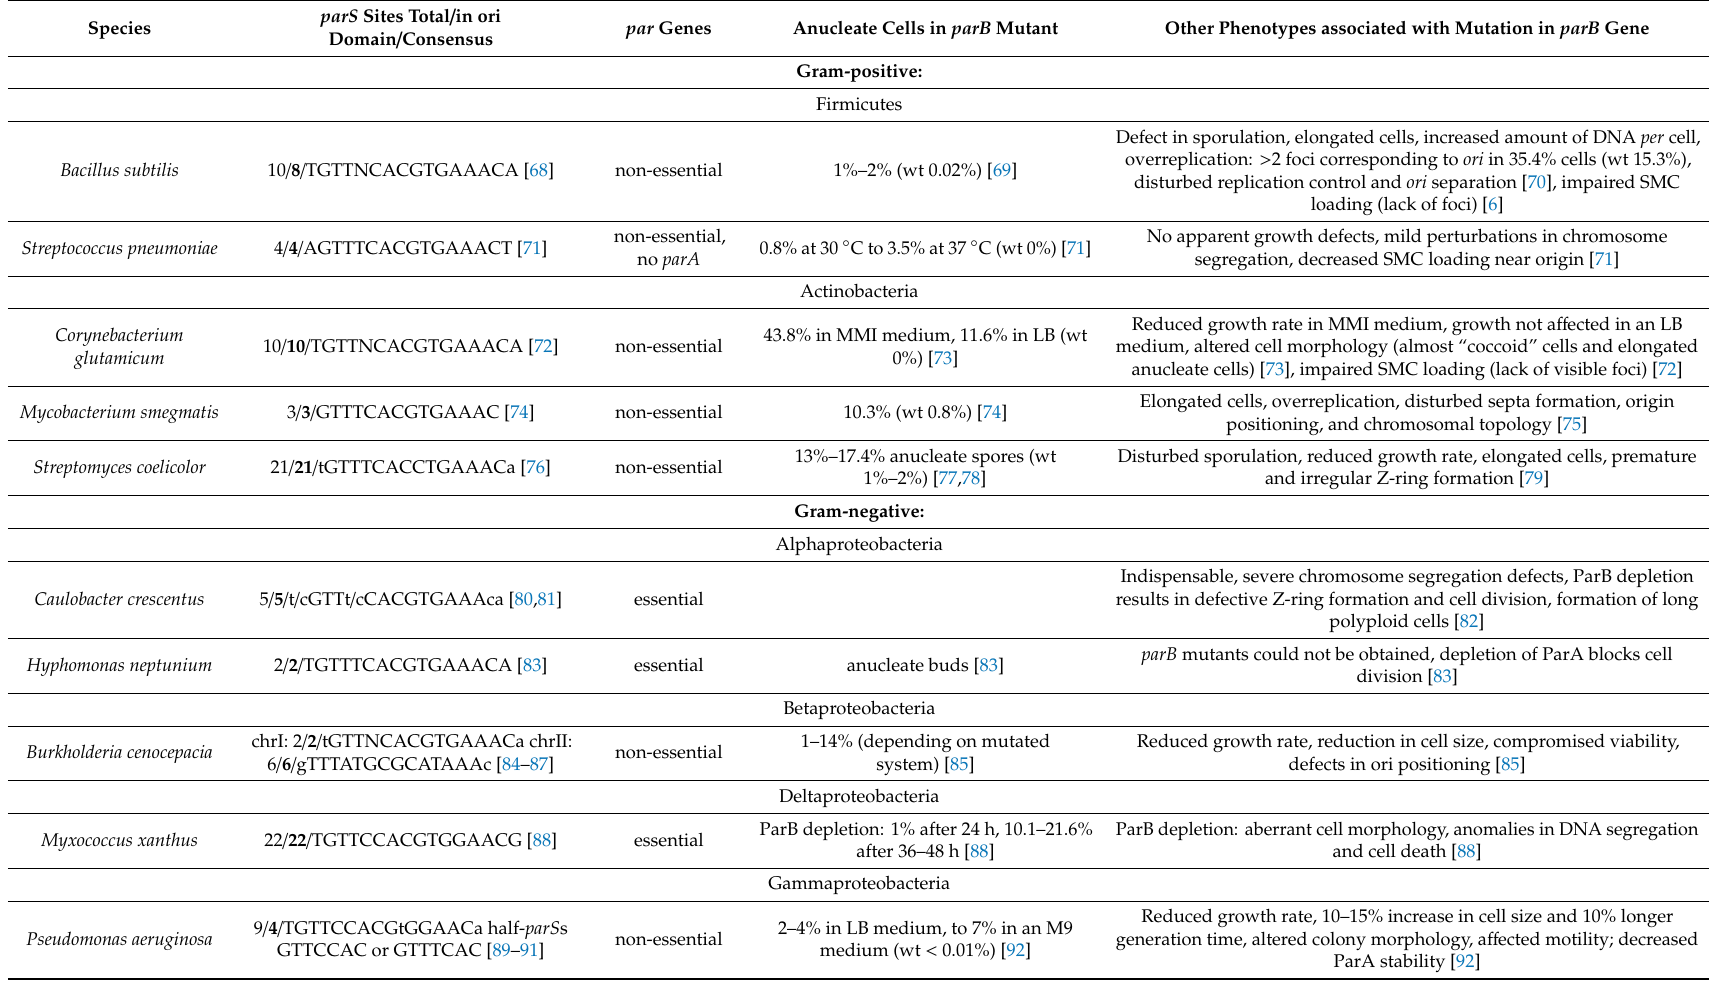
Table 1. Characterization of chromosomally encoded par